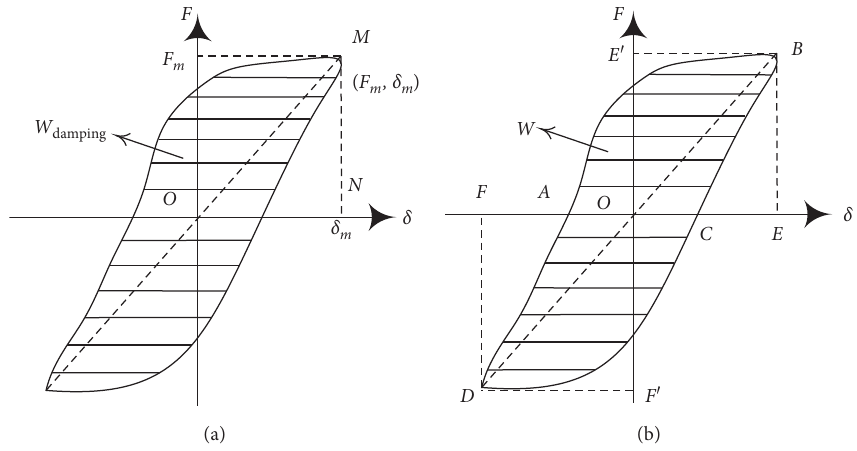
Figure 10: Hysteresis loop energy dissipation representative